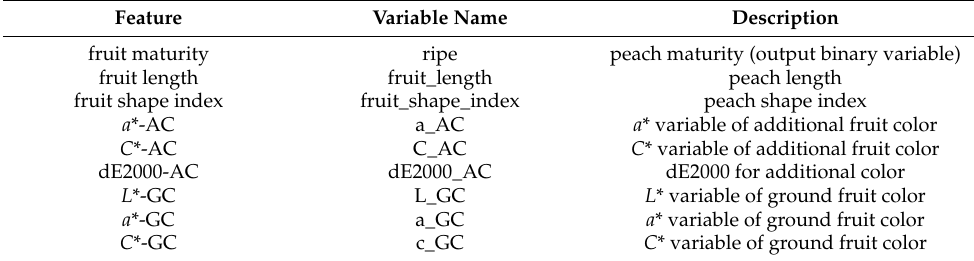
Table 1. A dataset with the list of variables used in model training.